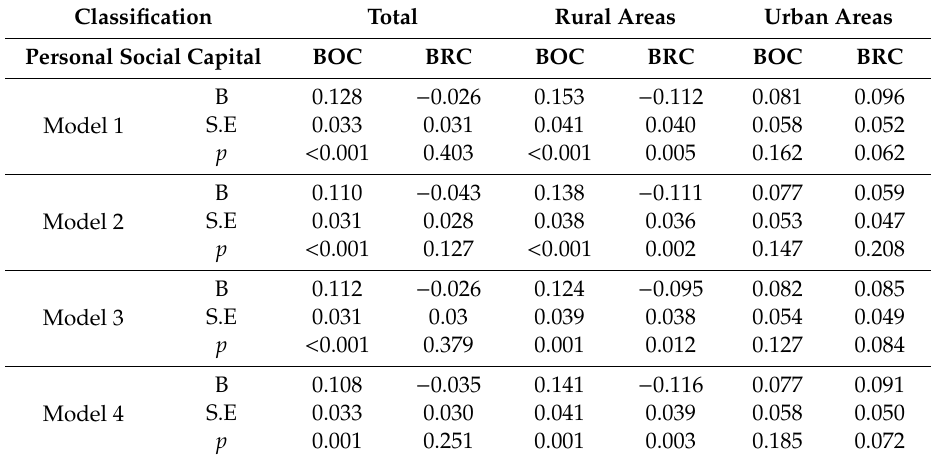
Table 3. Multiple linear regression model testing the association between personal social capital and loneliness. Classification Total Rural Areas